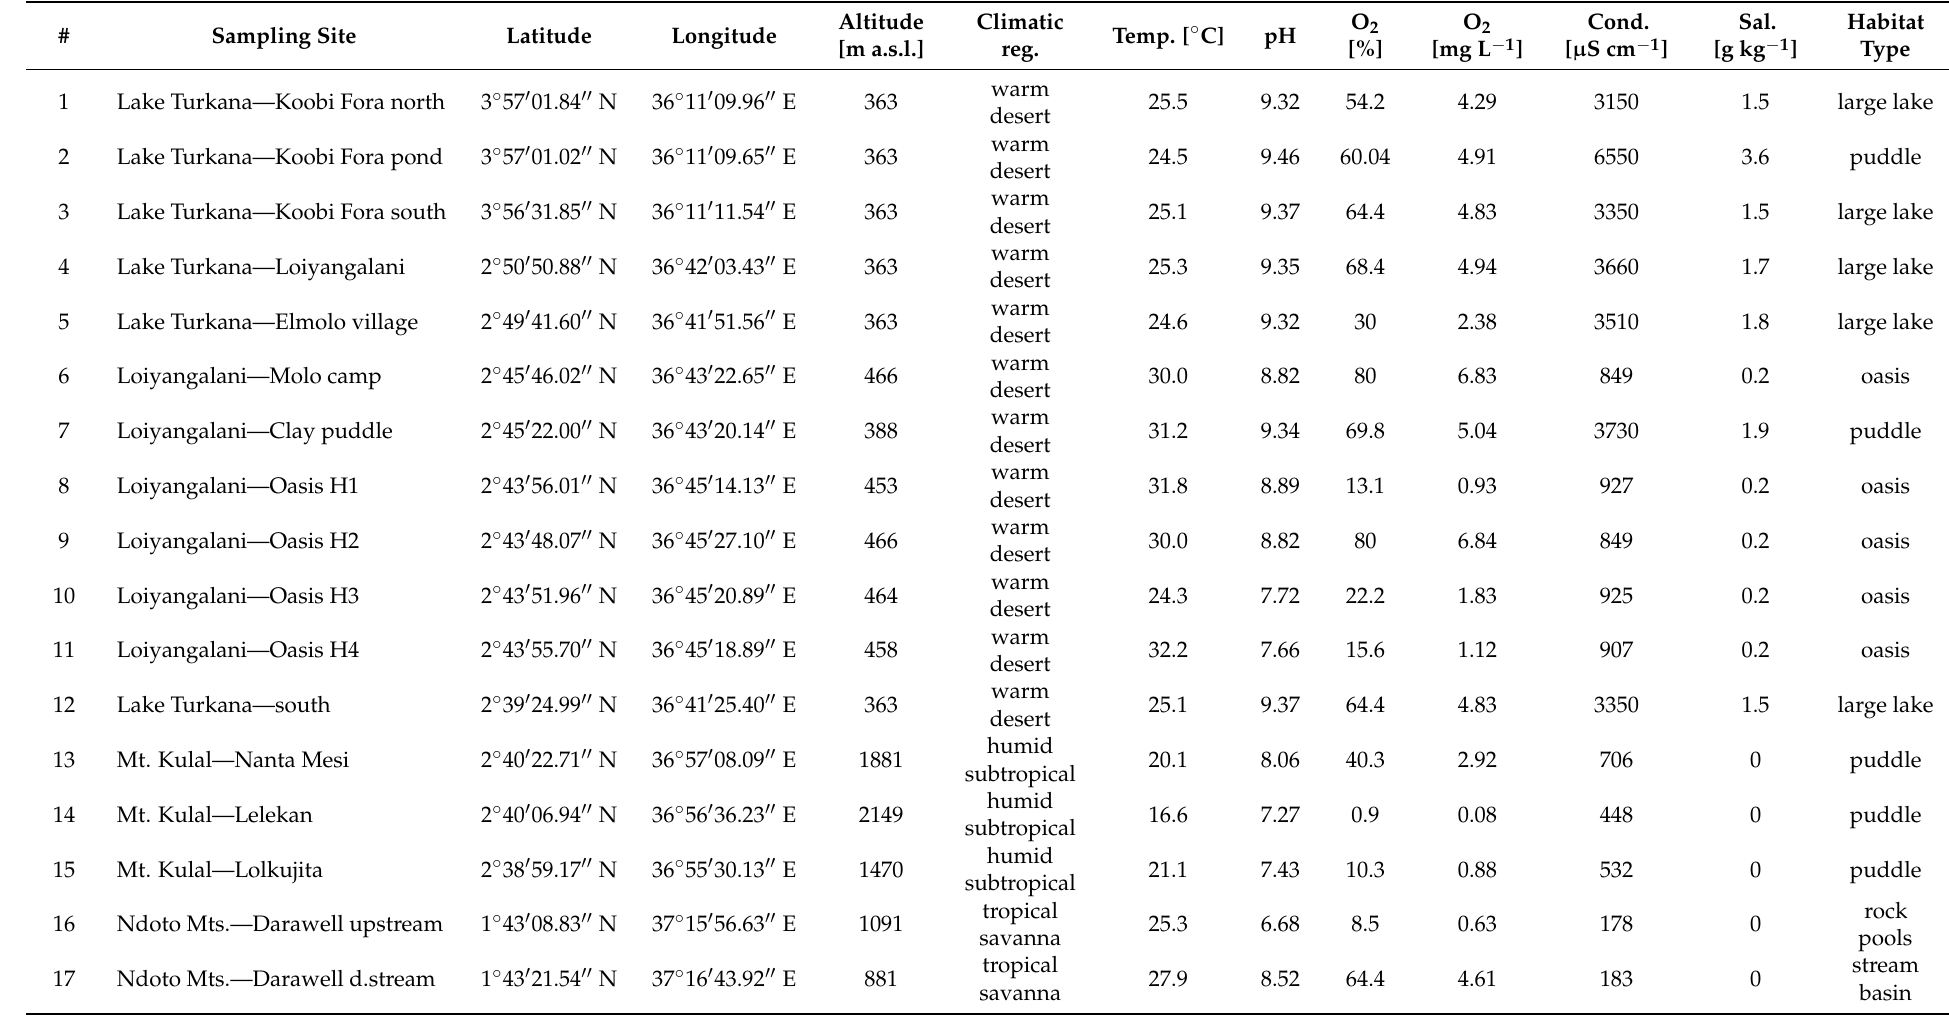
Table 1. List of the 33 sampled sites from 23 Kenyan waterbodies and their main environmental features. Sites ordered as in map (Figure 1). Temp = temperature; Sal. = salinity; artif. = artificial; d. = downstream; t. Mediterranean = temperate